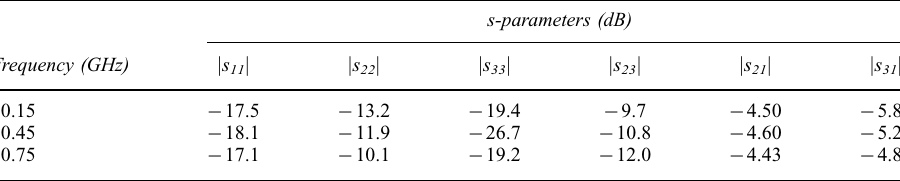
TABLE V Exact Measured Values of All Important s-parameters Into the Desired Frequency